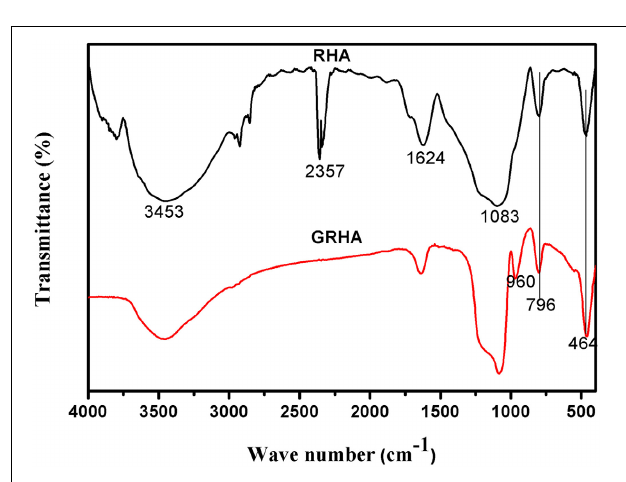
FIGURE 4 | FT-IR spectra of neat rice hush ash (RHA) and glycidyl functionalized rice husk ash.